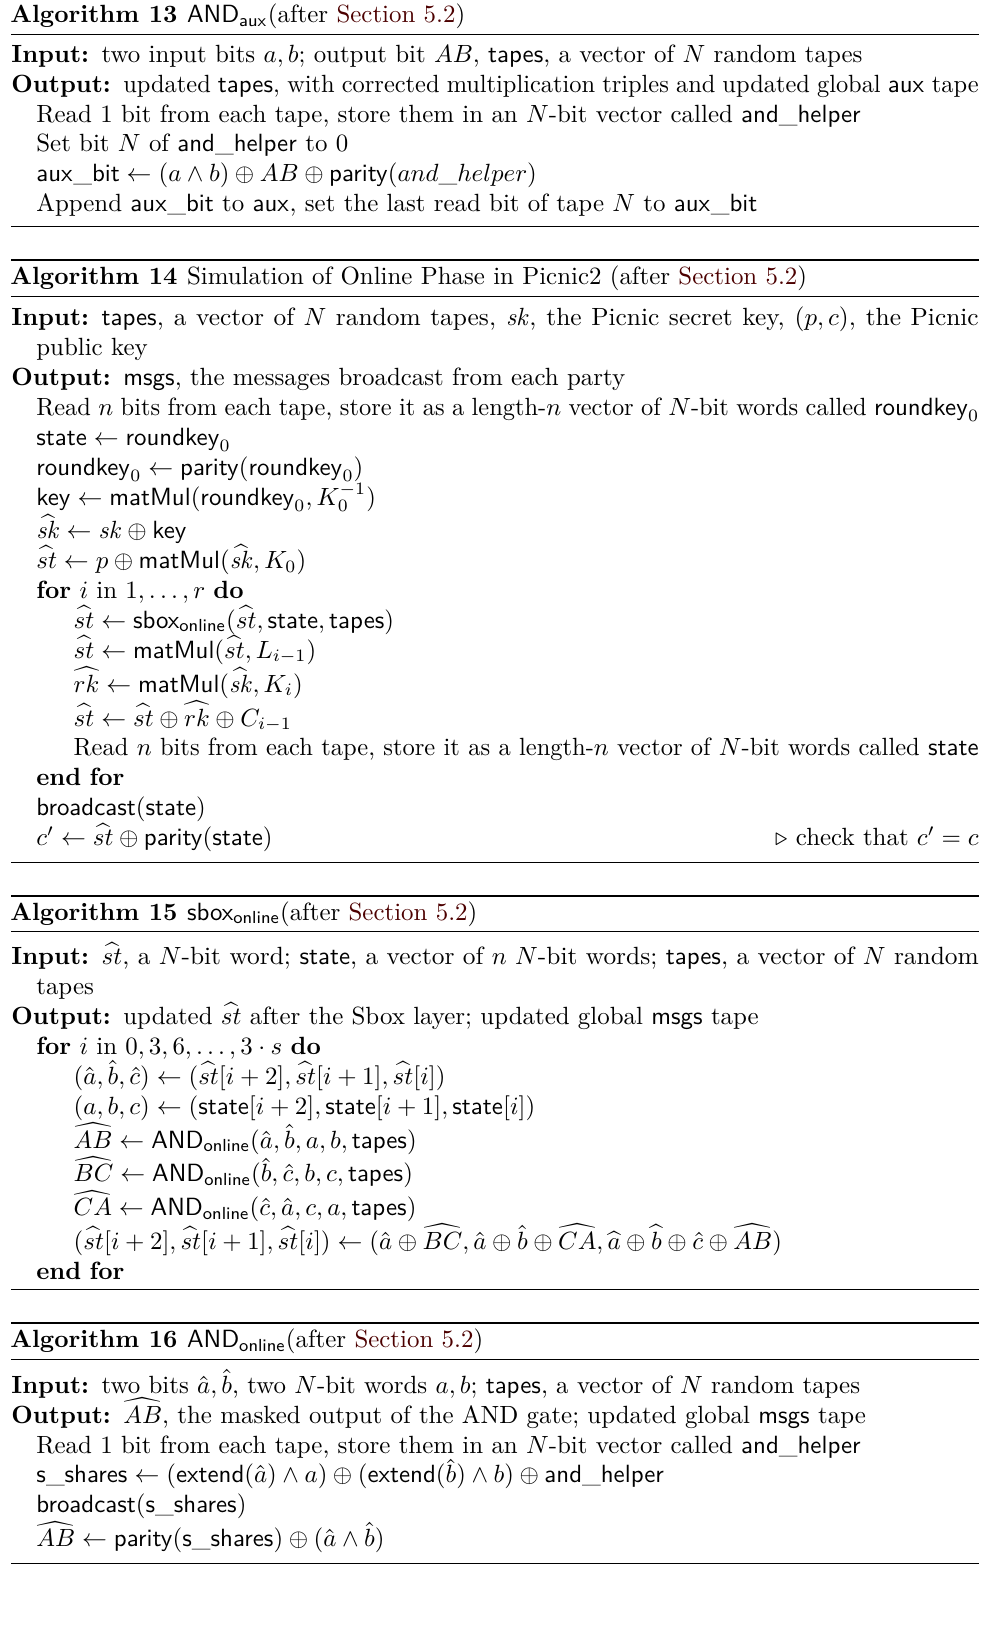
Algorithm 13 AND aux (after Section 5.2)